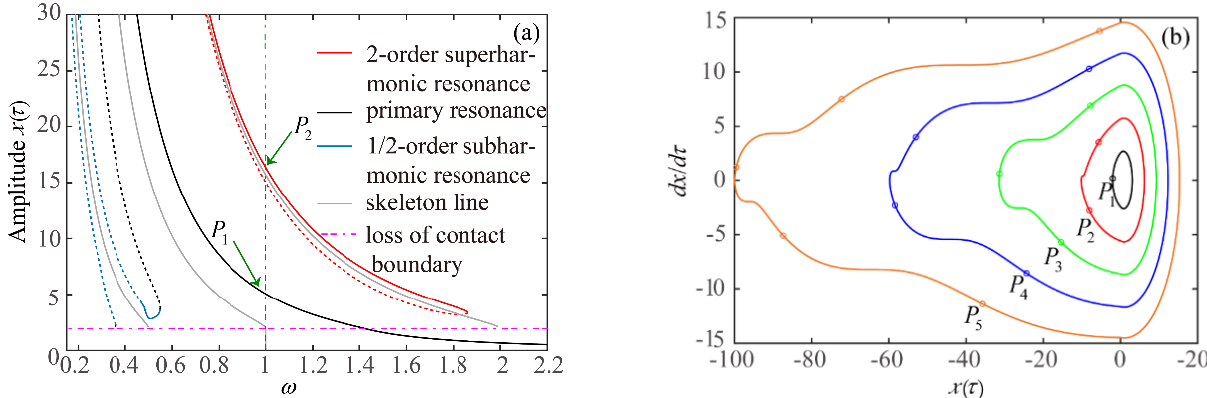
Figure 9. One-sided contact system for A = 1, ( a ) the frequency-response peak-to-peak curves, and ( b ) phase portraits their Poincare mapping dots of co-existing period- n solutions (i.e., P n ) when ω = 1.